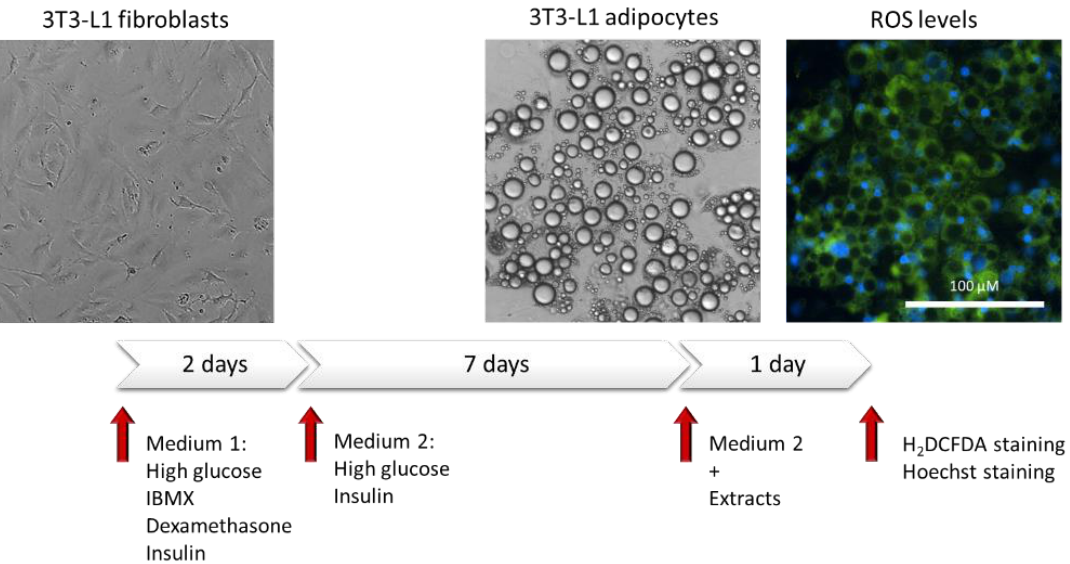
Figure 1. Cellular treatment scheme for ROS quantification. Representative images are shown above the timeline.